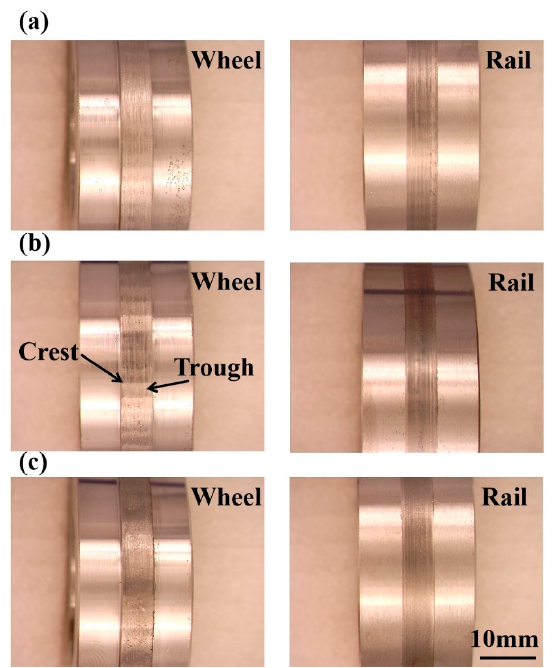
Figure 4. The surface macroscopic morphology of wheel and rail samples under different contact stress conditions: ( a ) 700 MPa; ( b ) 900 MPa and ( c ) 1200